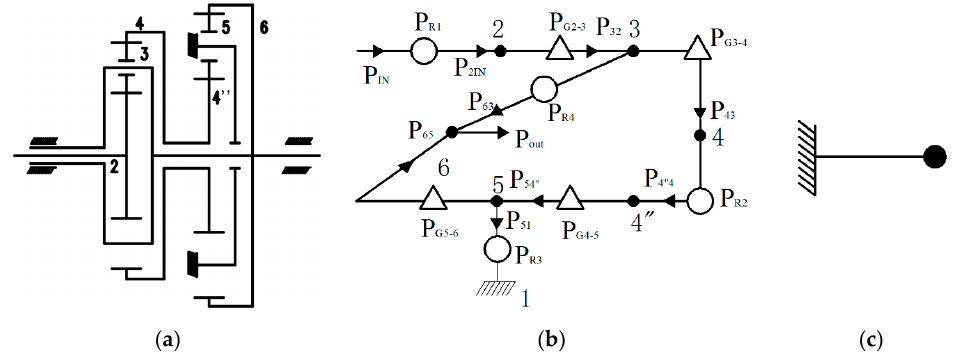
Figure 8. Double-stage herringbone planetary gear transmission system. ( a ) Schematic drawing; ( b ) power flow diagram; ( c ) graphical representation of fixed rotary.